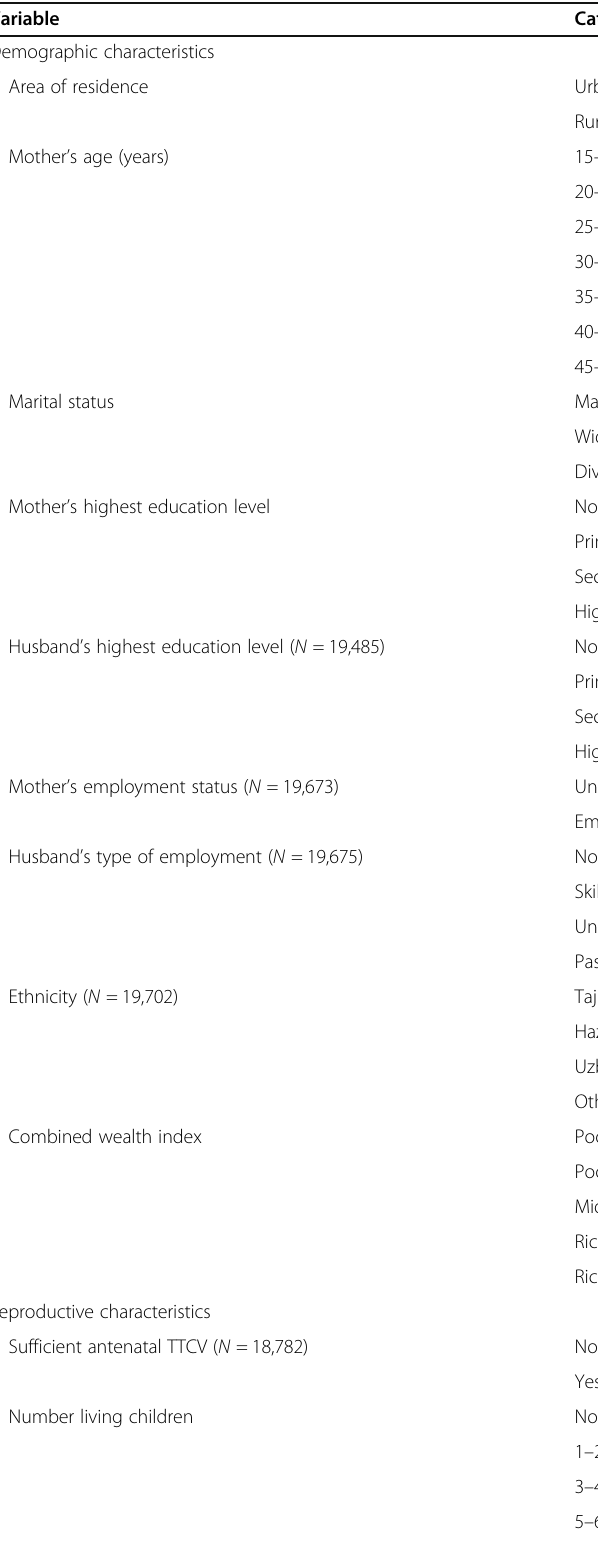
Table 1 Baseline characteristics of women ages 15 – 49 a , Afghanistan Demographic and Health Survey